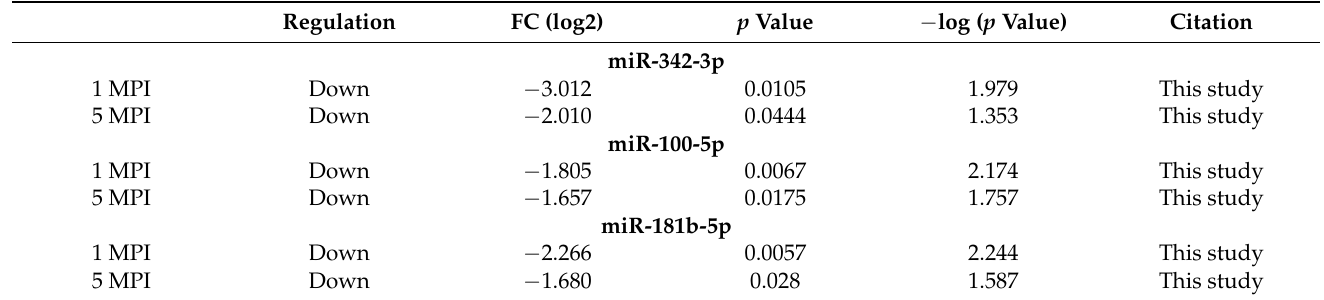
Table 5. Longitudinal regulation of EV-associated miRNAs by THC in virally suppressed